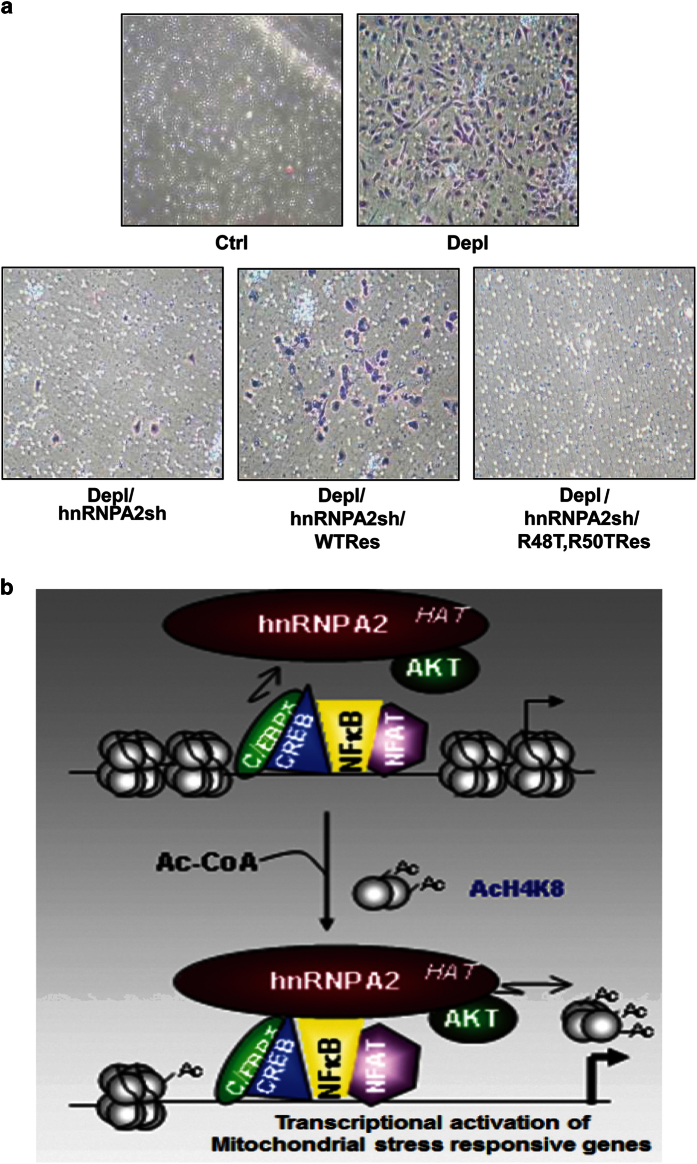
HnRNPA2 KAT activity is essential for the mtDNA depletion-induced invasive phenotype.
(a) Matrigel invasion assay in control, PmtDNA-depleted, PmtDNA-depl/hnRNPA2sh
cells and PmtDNA-depl/hnRNPA2sh cells expressing either WT or KAT mutant hnRNPA2. A
representative image from three independent experiments is presented. (b)
Schematic showing hnRNPA2 acetylates histone H4 at the promoter DNA of the mitochondrial
stress-target genes. Akt activated by MtRS phosphorylates hnRNPA2 and augments its KAT
activity. Histone acetylation by hnRNPA2 provides access to stress-activated
transcription factors NFκB, C/EBPδ, CREB and NFAT to the promoter DNA,
resulting in transcriptional activation of the stress-target genes.